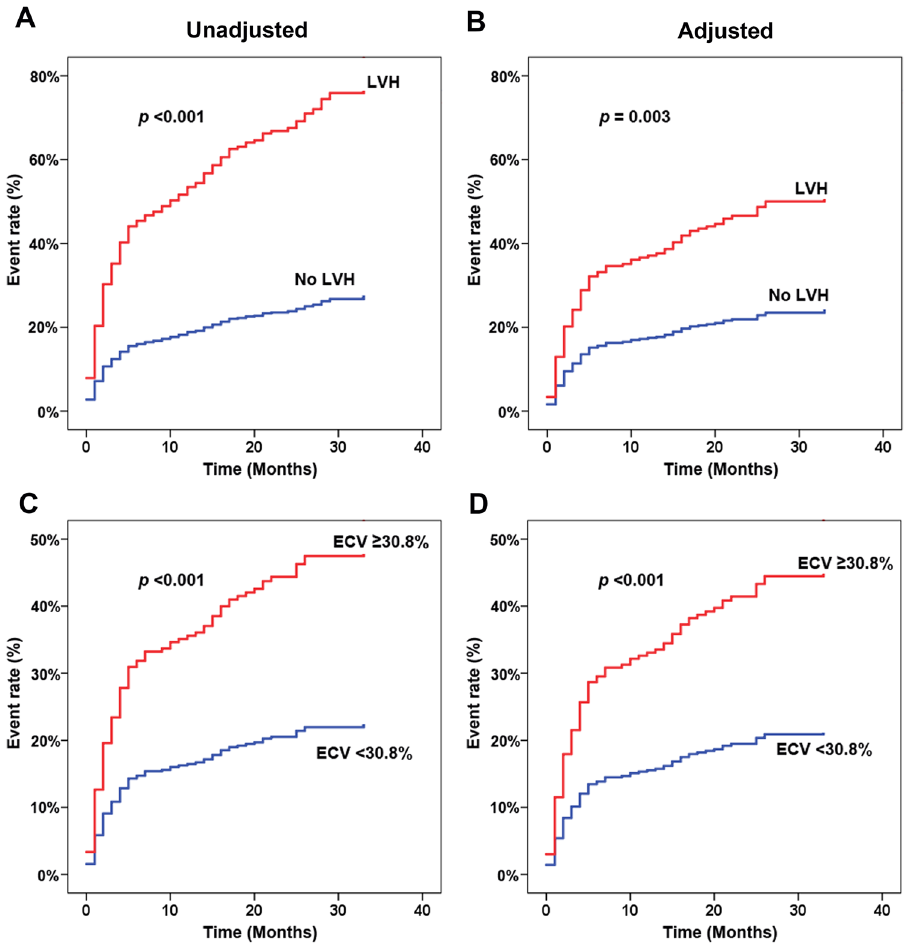
Figure 2. Cumulative incidence of cardiovascular event rate compared between LV hypertrophy (LVH) and no LVH: ( A ) unadjusted, ( B ) adjusted. Cumulative incidence of cardiovascular event rate compared between extracellular volume (ECV) < 30.8% and ECV ≥ 30.8%: ( C ) unadjusted, ( D )